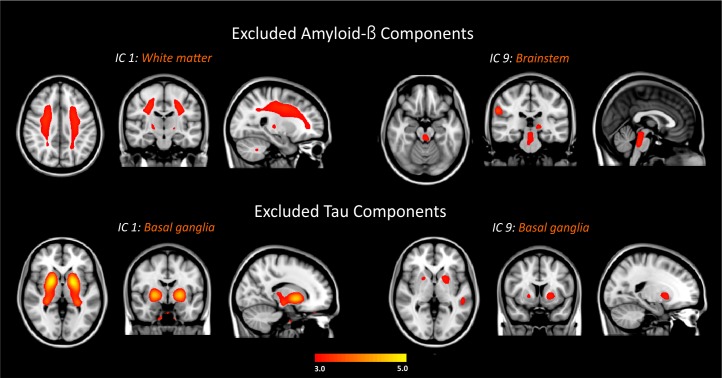
Excluded amyloid-β and tau components.The components were thresholded with a z-score >2.0.